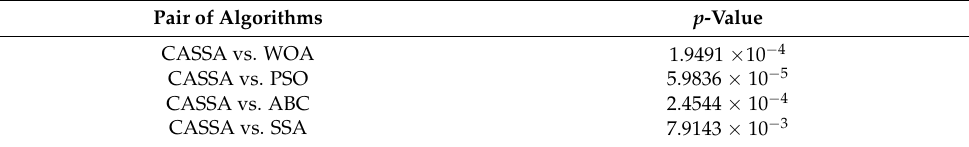
Table 5. Comparison of significance level results between CASSA and each algorithm. Pair of